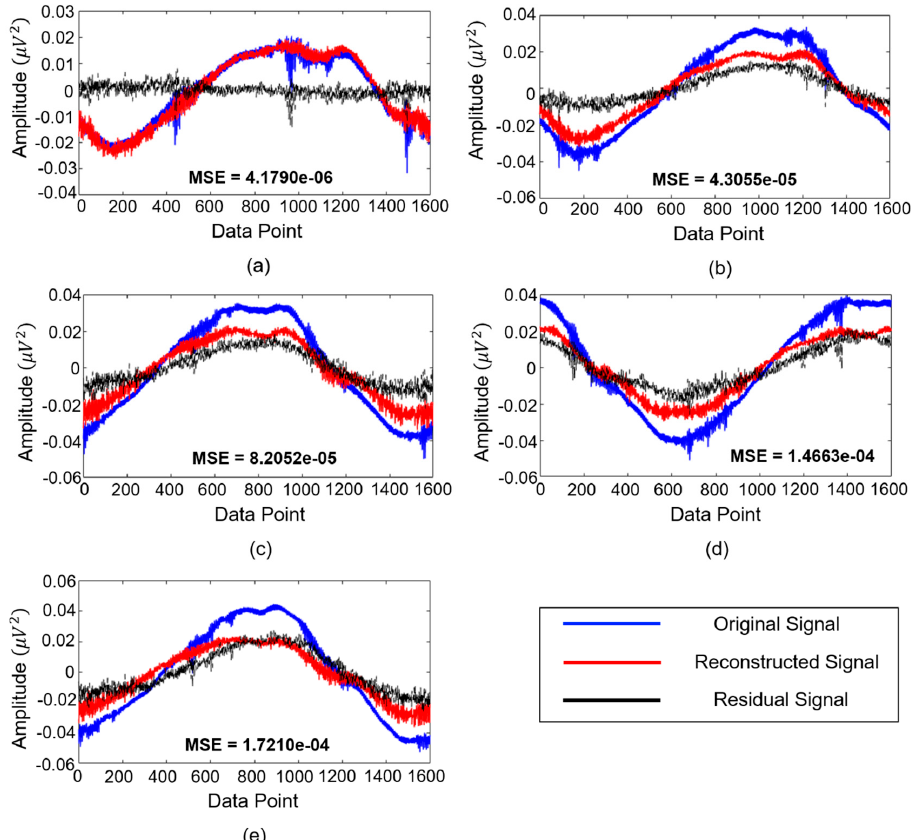
Figure 6. The original, reconstructed, and residual signal examples corresponding to signal classes of ( a ) normal operating condition, ( b ) 1.5 g shaft imbalance condition, ( c ) 1.7 g shaft imbalance + slight blade-rub fault condition, ( d ) 2.4 g shaft imbalance + intensive blade rub-fault, and ( e ) 2.8 g shaft imbalance + severe blade rub fault, respectively.